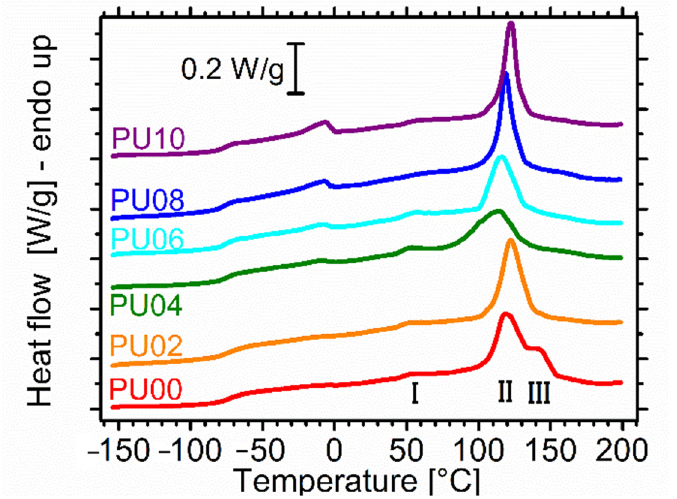
Figure 5. DSC heating curves for all materials under investigation. Curves are normalized to sample mass.